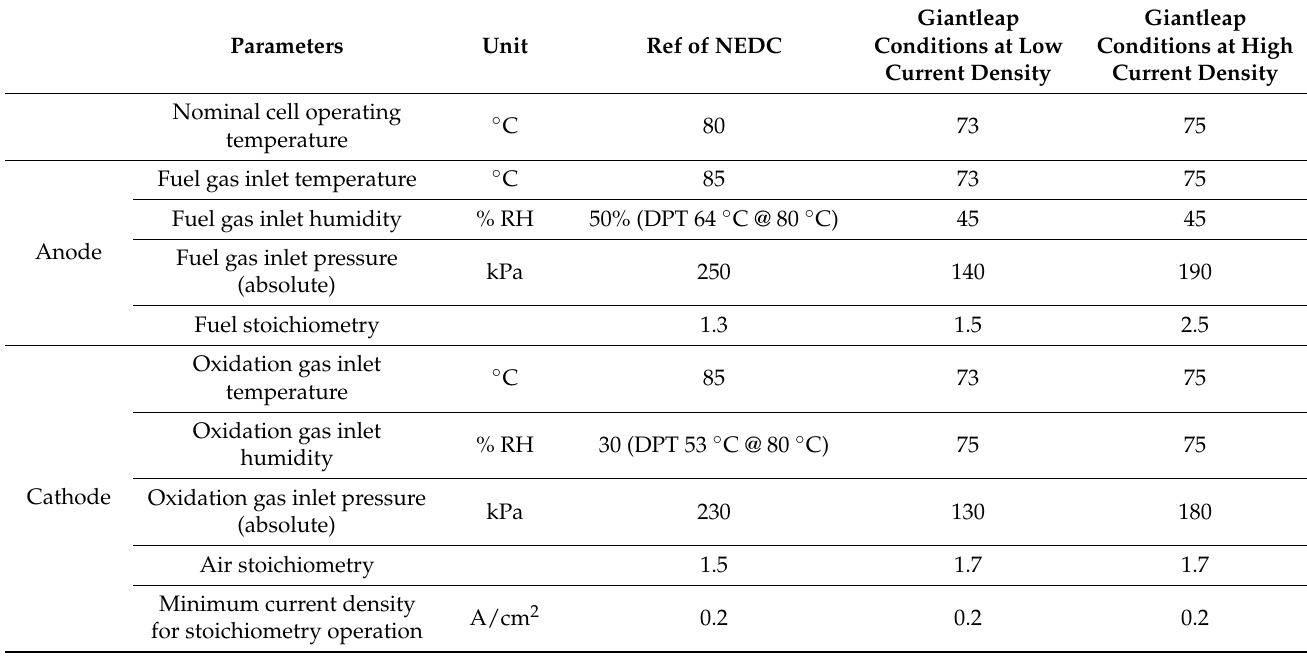
Table 5. Operating parameters of